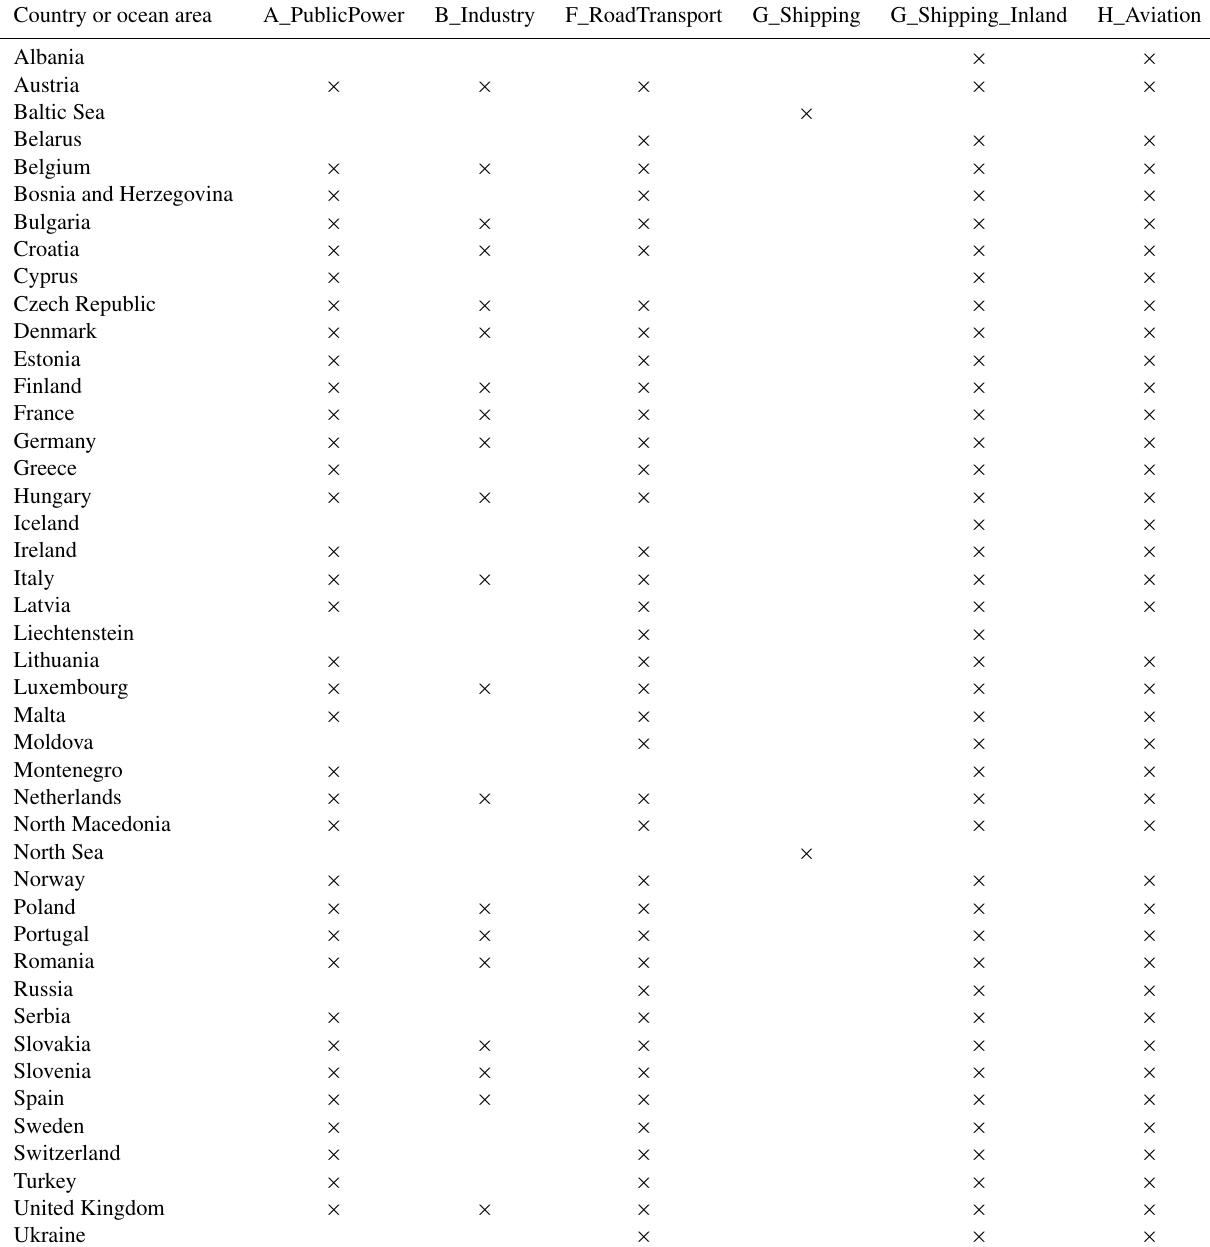
Table A1. Overview of available emission reduction information for countries in the investigated domain during the lockdown applied in this